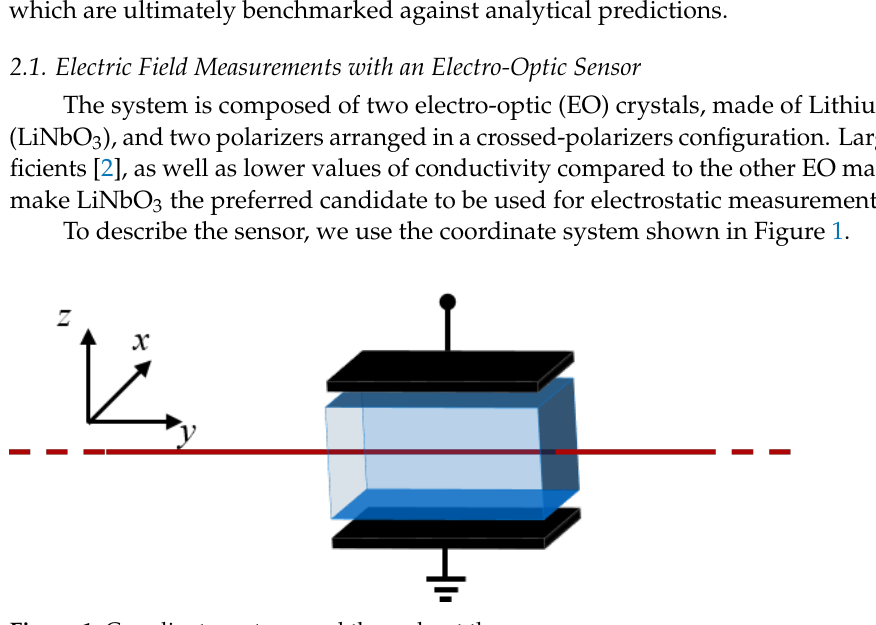
Figure 1. Coordinate system used throughout the